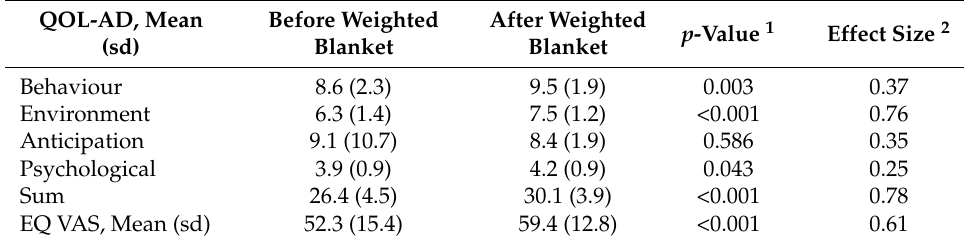
Table 1. QoL before and after utilisation of weighted blanket for 28 days, n = 68.